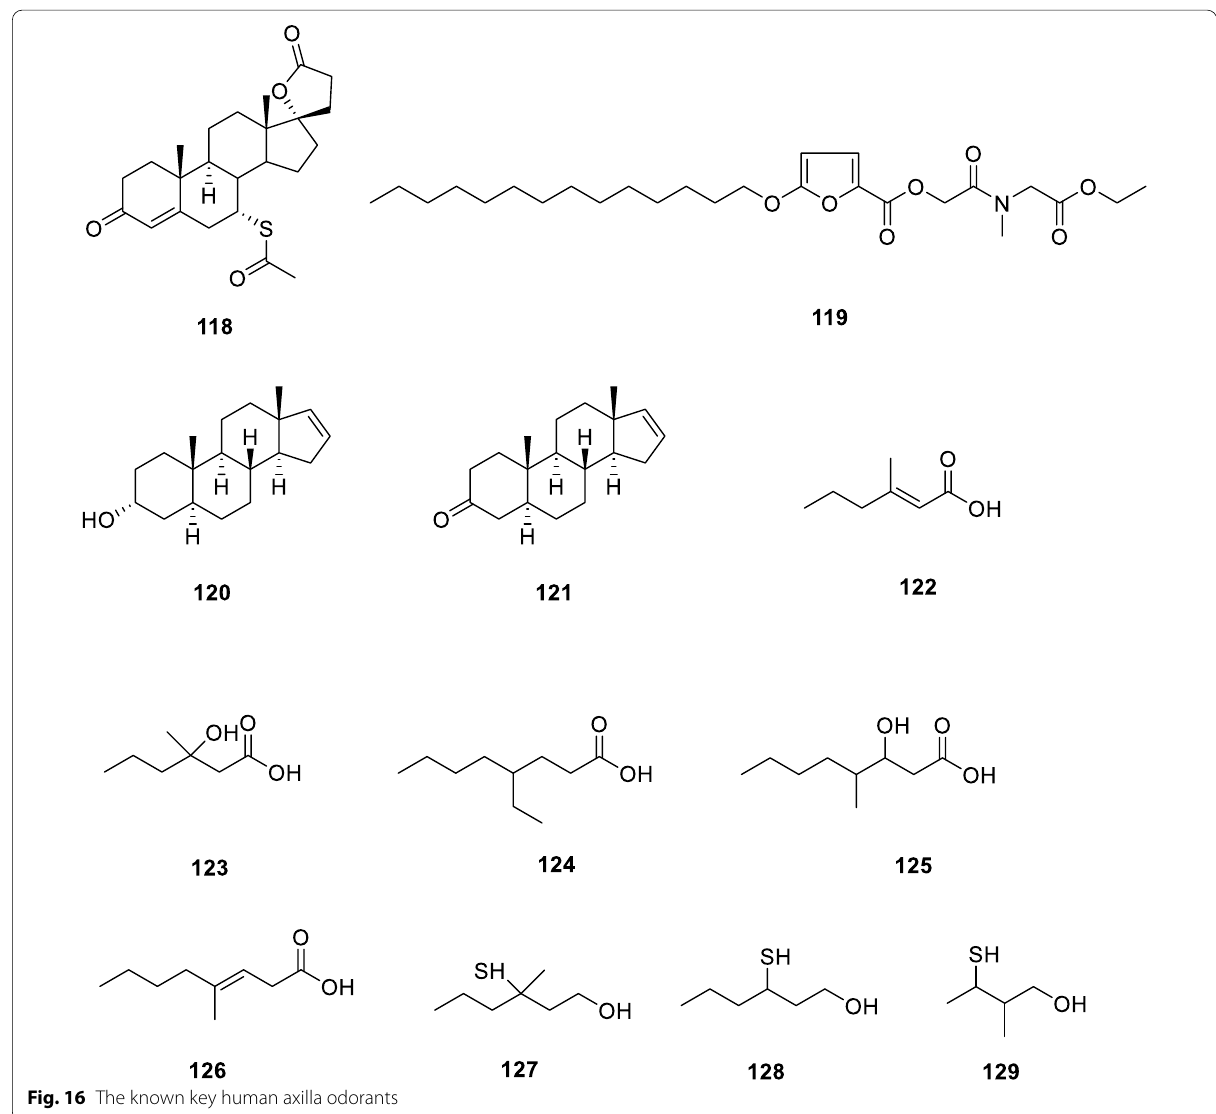
Fig. 16 The known key human axilla